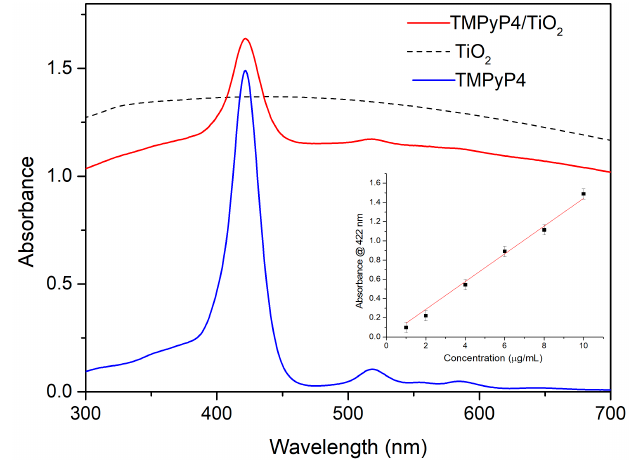
Figure 4. The absorption spectra for 0.01 mg/mL TMPyP4 water solution, 0.12 mg/mL TiO 2 water suspension, and TMPyP4/TiO 2 complexes water suspension. The inset shows the calibration curve for the determination of TMPyP4 concentration in the complexes.